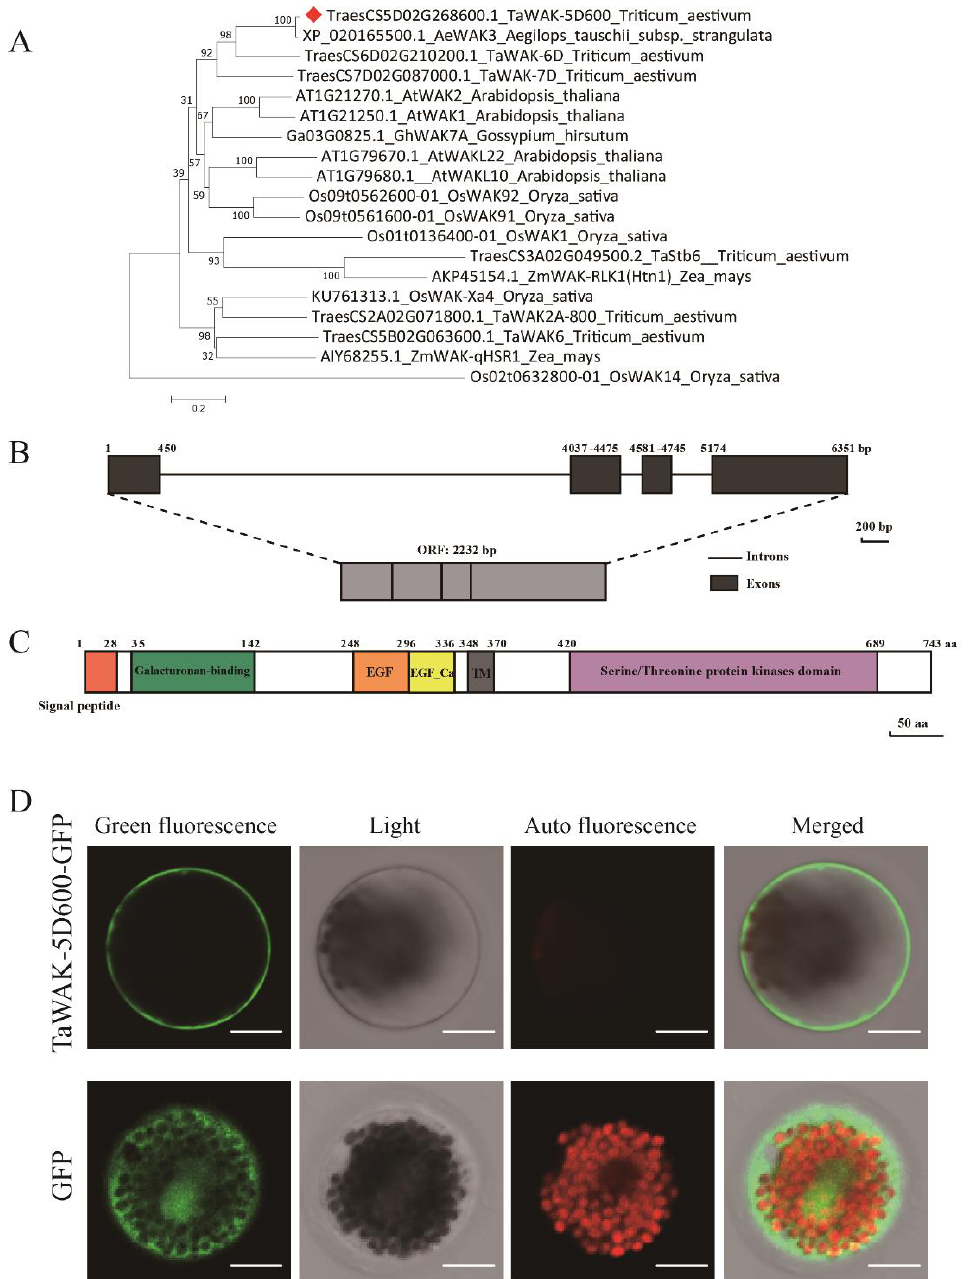
Figure 4. Phylogenetic tree, conserved-domain, and gene-structure analyses of TaWAK-5D600 . ( A ) A phylogenetic tree of TaWAK-5D600 and other 18 WAK proteins from different plants. The position of TaWAK-5D600 was indicated by a red blot. ( B ) Gene structure of TaWAK-5D600 ; black boxes represent exons and black lines indicate introns. ( C ) Schematic diagram of the TaWAK-5D600 protein. The conserved protein domains of TaWAK-5D600 were represented by different colored boxes. ( D ) Subcellular localization of TaWAK-5D600 in wheat protoplasts cells (bars = 20 μm) .